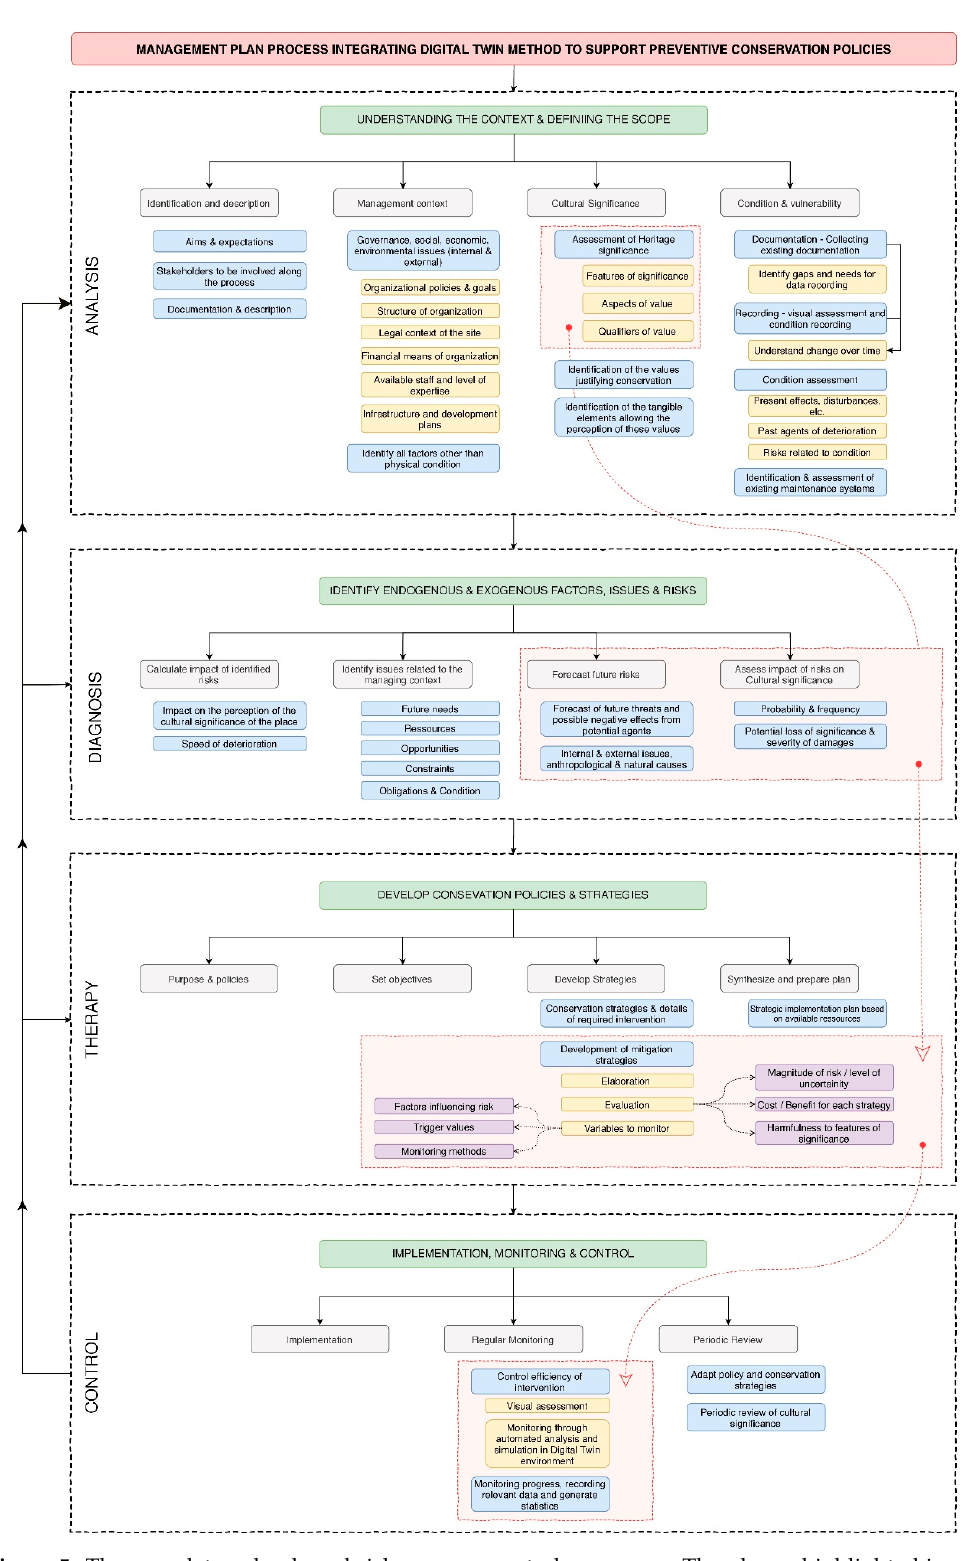
Figure 5. The complete value-based risk management plan process. The phases highlighted in red are the key steps towards the implementation of the method, further discussed in the next chapter (Section 4.2).